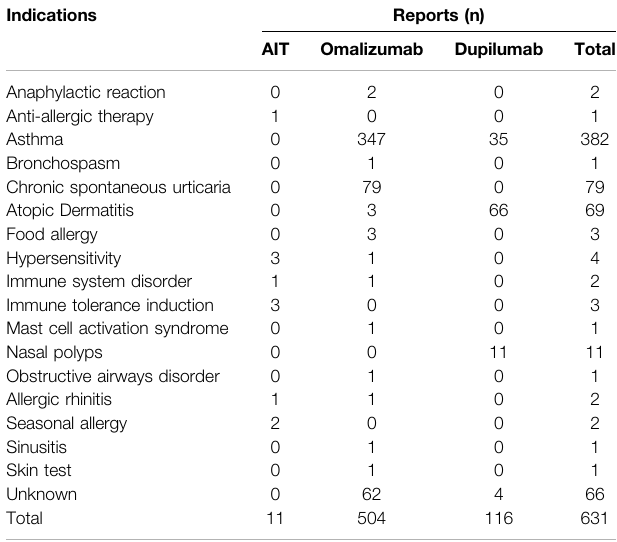
TABLE 4 | Demographic characteristics of cases with AIT, omalizumab, and dupilumab associated anaphylaxis in children. Characteristics